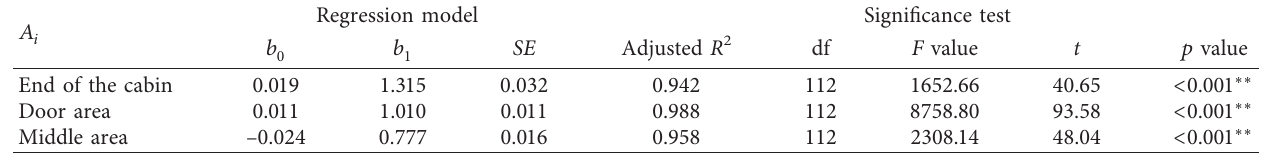
Table 4: Prediction model of passenger occupancy rate of the area.